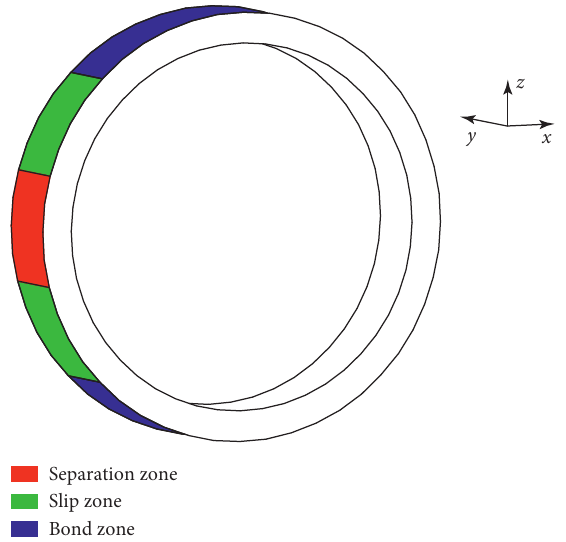
Figure 10: Separation and slip zone distributions of rock-lining contact interface after